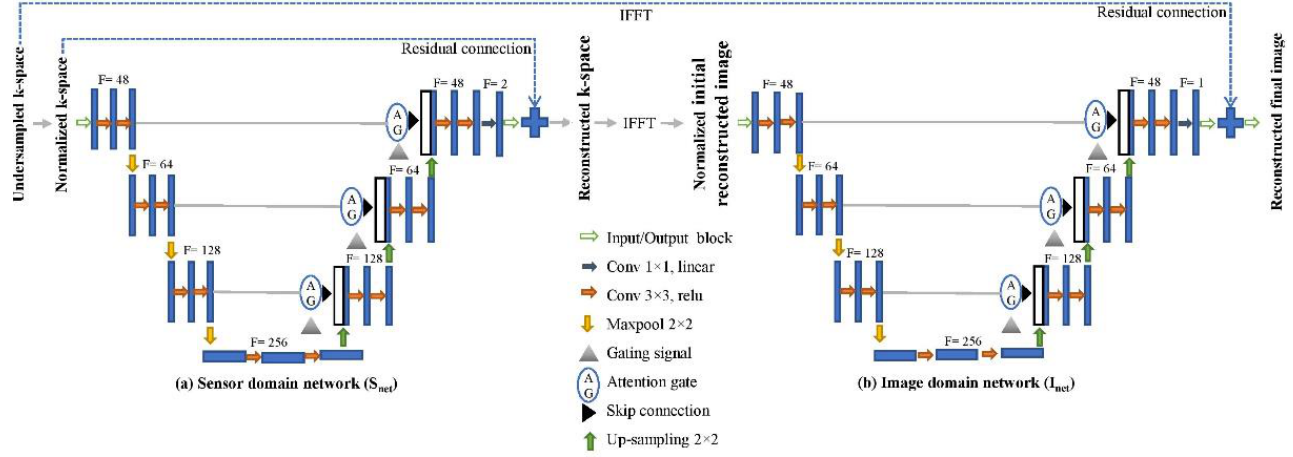
Figure 3. Proposed dual-domain residual attention convolutional neural network (RA-CNN)